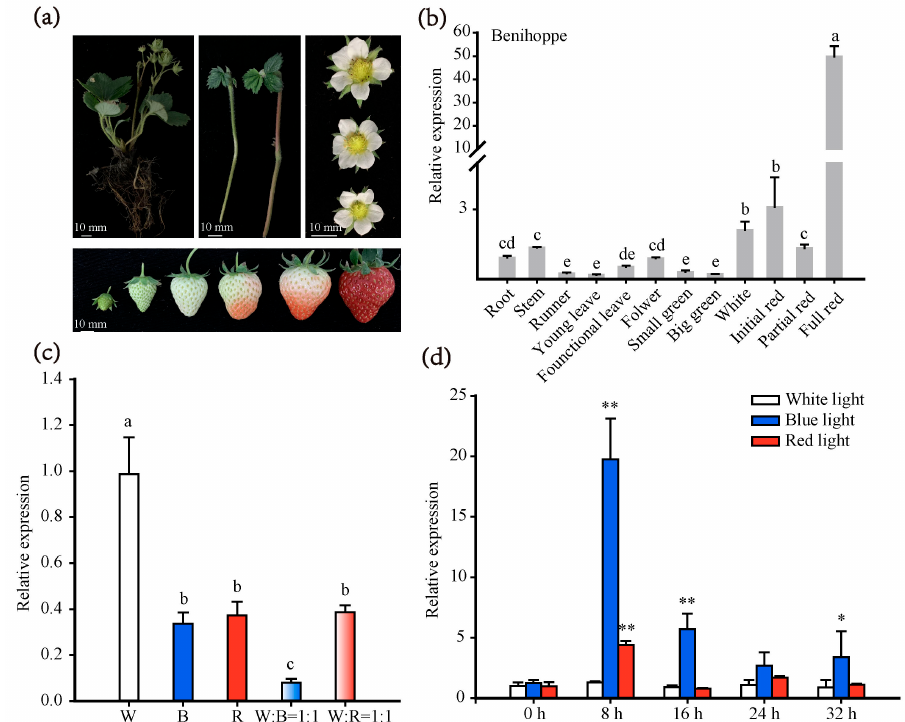
Figure 2. Expression characteristics of FaWRKY71 . ( a ) Diagrams about different tissues of ‘Benihoppe’. Scale bars represent 10 mm. (b) Spatial and temporal expression of FaWRKY71 in different tissues and different developmental stages of strawberries. Multiple comparisons were tested using Turkey’s test and significant differences (P < 0.05) were indicated by different lowercase letters. (c) Effects of different light qualities on FaWRKY71 gene expression in strawberry full red fruits. W (White light); B (Blue light); W: B = 1:1 (White light: Blue light = 1:1); W: R = 1:1 (White light: Blue light = 1:1). (d) Effects of different light qualities on FaWRKY71 gene expression in tissue culture seedlings of strawberry. Error bars were SEs for three replicates, and statistical significance was determined with the white light by Student’s t-test (**, P < 0.01; *, P < 0.05).